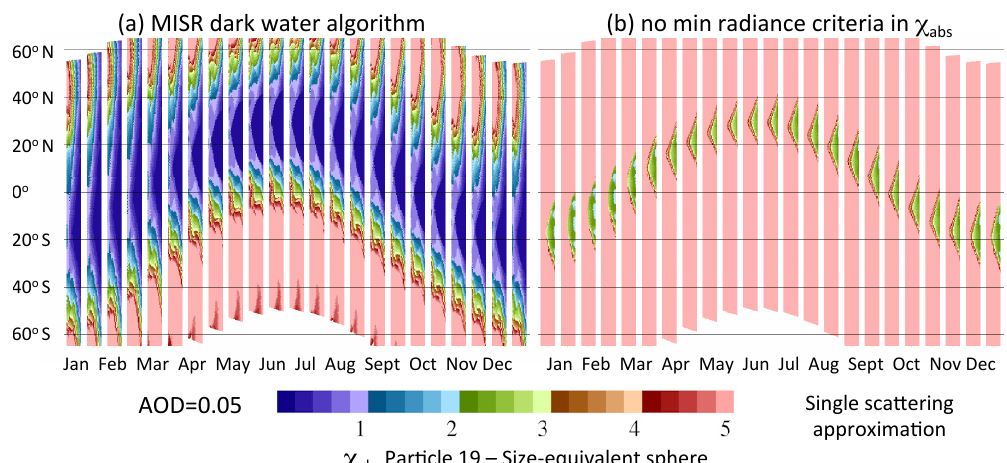
Fig. 13. χ 2 calculated for MISR red and NIR wavelengths only, comparing MISR Particle 19 and the size-equivalent spherical particle, abs presented as a function of latitude and time in the same manner as Fig. 6. The plots take into account the changing viewing geometry, using the single-scattering approximation for AOD=0.05 assuming a black surface, including the effect of cameras excluded due to potential sunglint contamination. In the MISR V22 Dark Water retrieval algorithm, χ 2 values less than 2 mean that the particles are indistinguishable abs from one another. Larger values of χ 2 indicate greater distinguishability. (a) Calculation of χ 2 as done in the V22 Dark Water algorithm. abs abs (b) Calculation of χ 2 excluding the radiometric abs